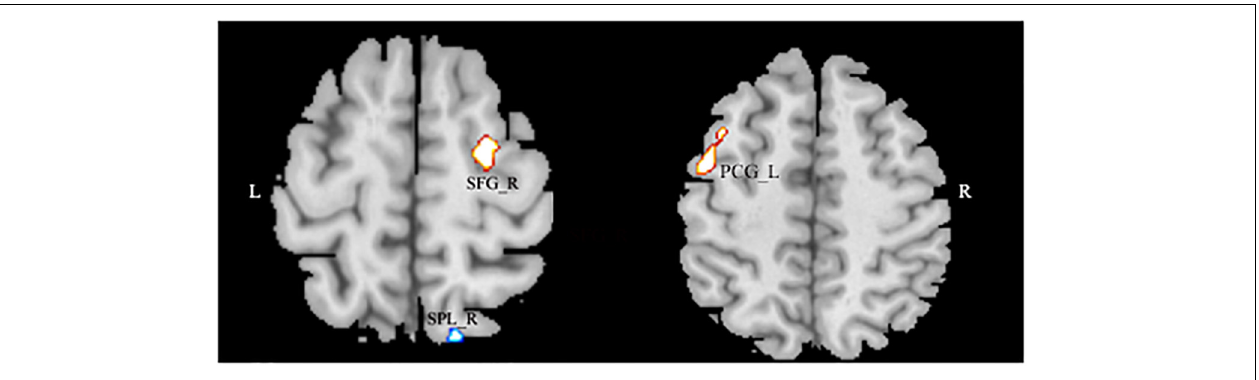
FIGURE 2 | The significant negative correlation between gray matter volume and Autism Spectrum Quotient score showing areas in the left superior frontal gyrus and in the right precentral gyrus, and negative in the right superior parietal lobule. Alphasim-corrected cluster level p < 0.05, voxel-wise level p < 0.005.